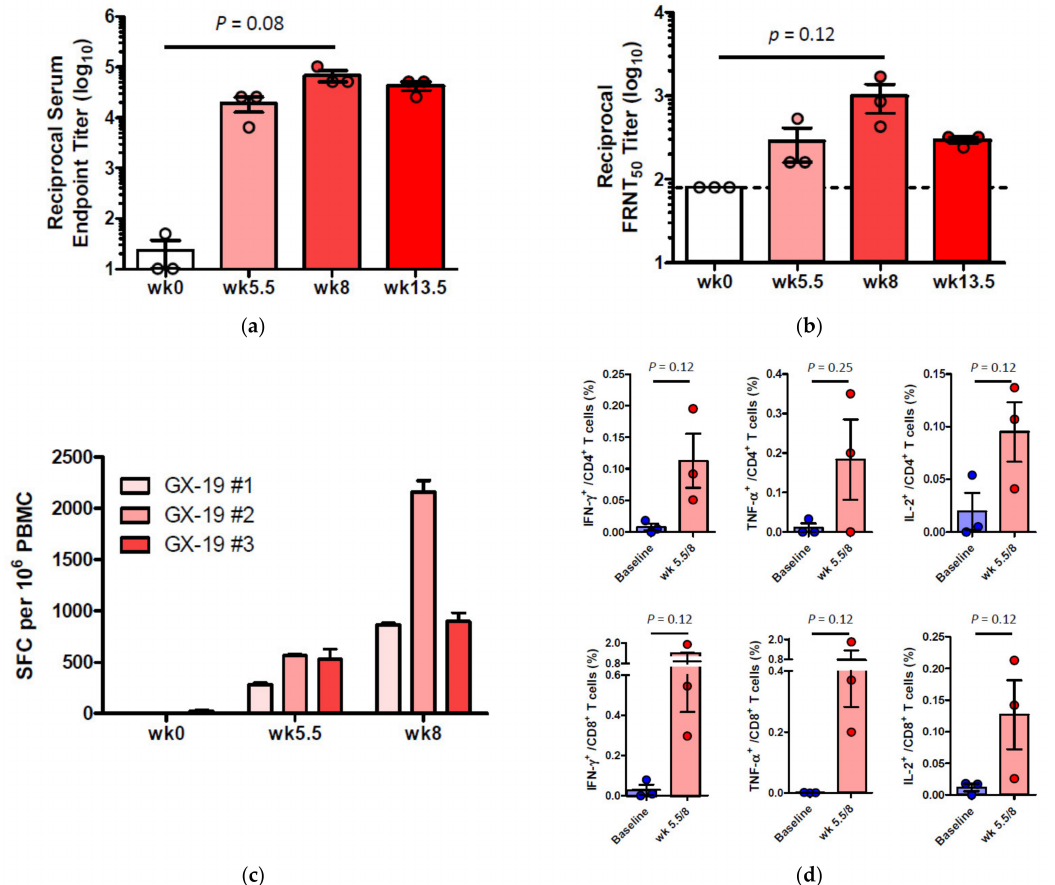
Figure 4. Antibody and T cell responses after GX-19 vaccination in macaques. Macaques ( n = 3) were immunized with 3 mg of GX-19 as described in the Methods. Serum and PBMCs (peripheral blood mononuclear cells) were collected before (week 0), during (week 4 and 5.5), and after (week 8) vaccination and were assessed for SARS-CoV-2 S-specific IgG antibodies by ELISA ( a ) and neutralizing antibodies against SARS-CoV-2 live virus ( b ). Data represent mean SEM of individual macaques (GX-19 #1, GX-19 #2, GX-19 #3), and dashed line indicates the assay limits of detection. The number of SARS-CoV-2 S-specific IFN- γ -secreting cells in PBMCs was determined by IFN- γ ELISPOT assay after stimulation with peptide pools spanning the SARS-CoV-2 S protein. Shown are spot-forming cells (SFC) per 10 6 PBMCS in triplicate wells ( c ). The frequency of S-specific CD4 + or CD8 + T cells producing IFN- γ , TNF- α , or IL-2 was determined by intracellular cytokine staining assays stimulated with SARS-CoV-2 S peptide pools. Shown are the frequency of S-specific CD4 + or CD8 + T cells after subtraction of background (DMSO vehicle) ( d ). Data of ( a , b , d ) are represented as individual values. p -Values determined by the Wilcoxon matched-pairs signed rank test; p -values are